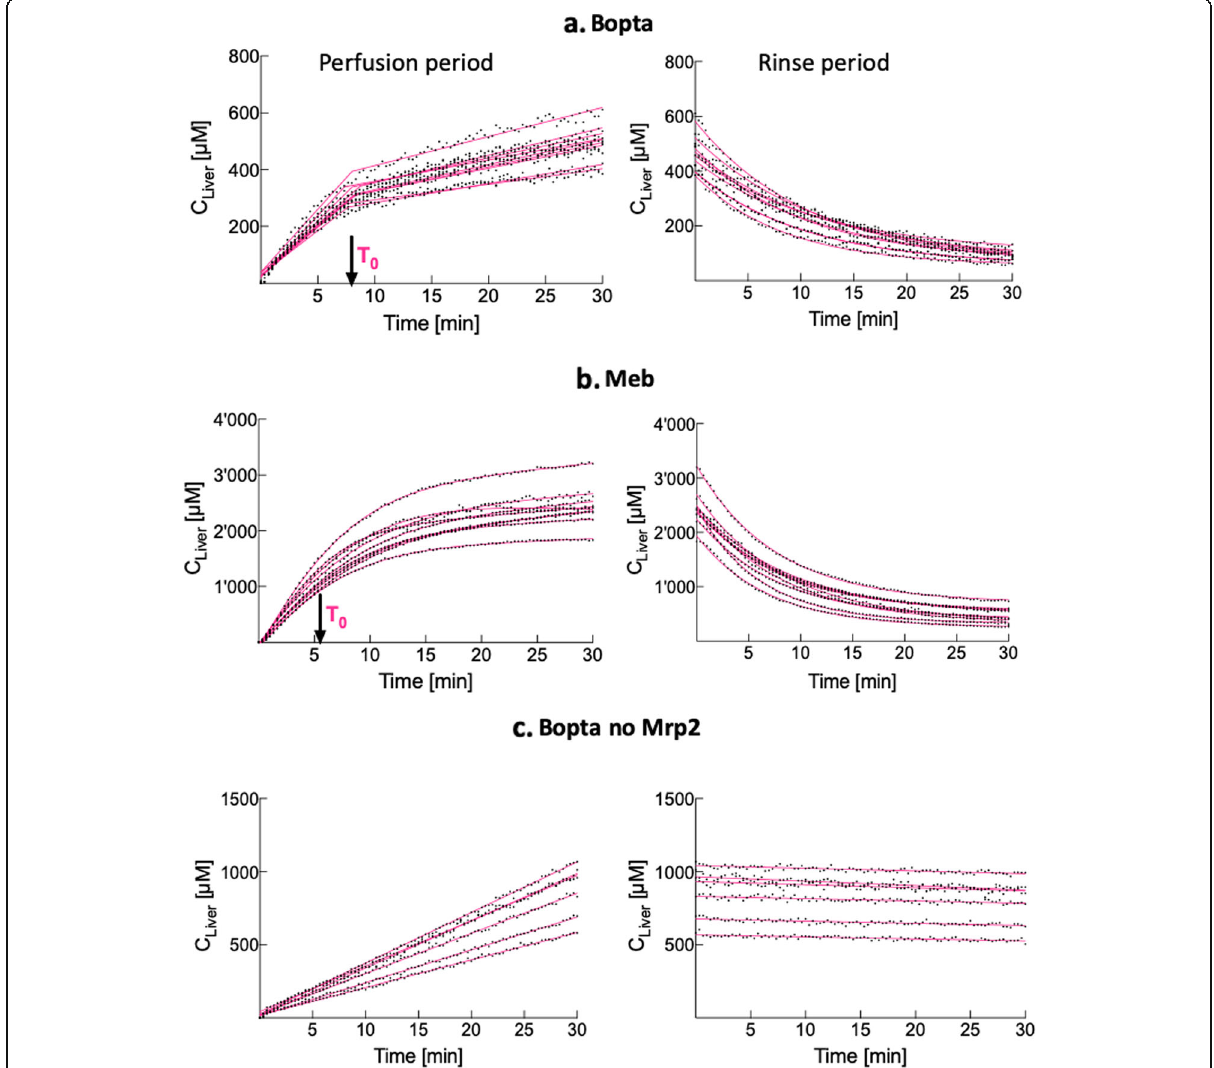
Fig. 3 Accumulation and decay of Bopta and Meb liver concentrations. a Normal livers ( n = 9) perfused with Krebs-Henseleit bicarbonate solution (KHB) + 200 μ M Bopta (left panel) and KHB (right panel). b Normal livers ( n = 9) perfused with KHB + 64 μ M Meb (left panel) and KHB (right panel). c Cholestatic livers lacking Mrp2 ( n = 6) perfused with KHB + 200 μ M Bopta (left panel) and KHB (right panel). Bopta accumulation in normal liver ( a ) fitted a segmental linear regression, whilst MEB accumulation ( b ) fitted a continuous hinge function (gentle connections between the two lines). Both regressions are described by two lines L 1 and L 2 intersecting at T 0 or time when bile excretion started to impact the accumulation. In livers lacking Mrp2, Bopta accumulation ( c ) fitted a single linear regression. During the rinse period, liver concentration decay fitted a one-phase decay for Bopta and Meb ( a , b , right). No Bopta decay was observed in the absence of Mrp2 ( c ,